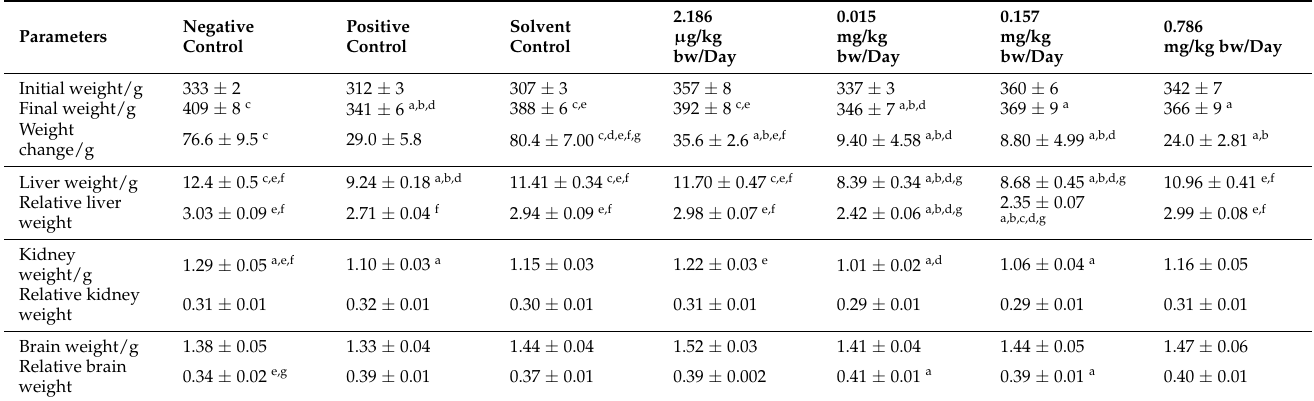
Table 1. Body, liver, kidney, brain, and relative organ weights of adult male Wistar rats in control and α -cypermethrin-treated